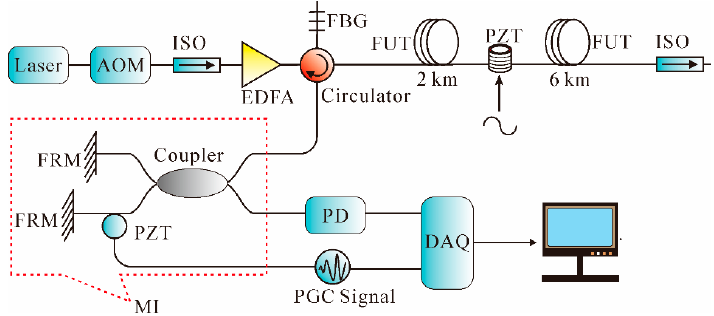
Figure 16. Experimental setup of a distributed vibration sensing system merging the MI and Φ -OTDR systems based on the PGC algorithm, adapted from Fang et al. [142] .